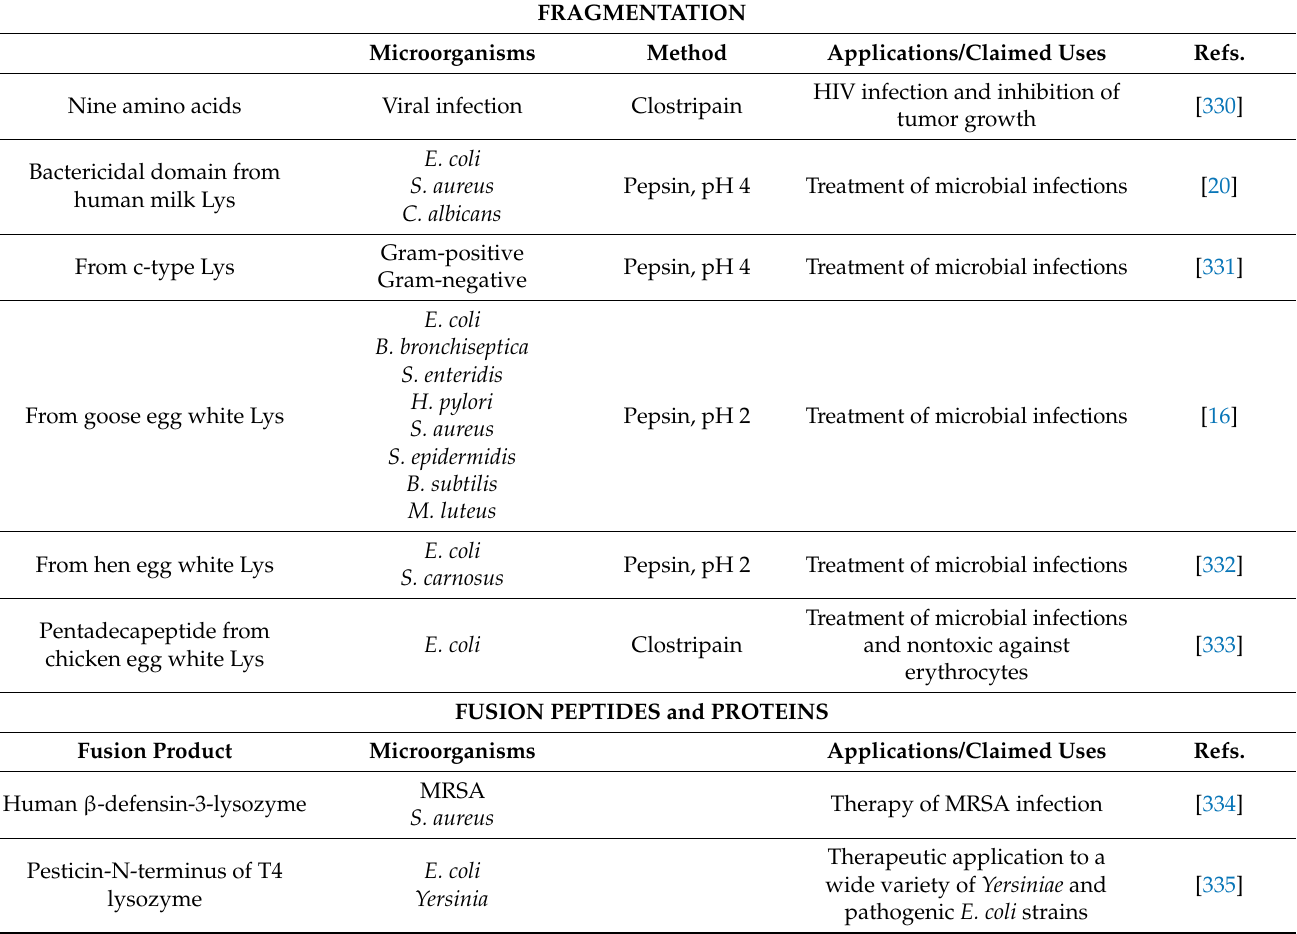
Table 7. Chemical modifications of